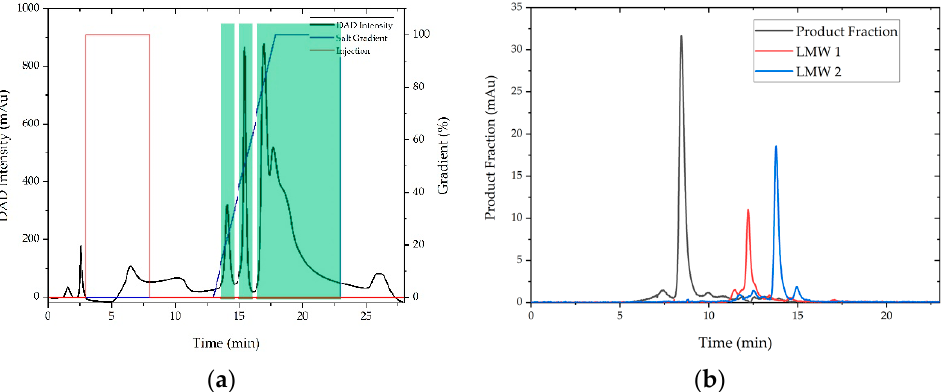
Figure 1. IEX Chromatogram of a 10 CV salt gradient ( a ), marked in green are the different eluent fraction. On the right ( b ) a representative SEC chromatogram of each eluent fraction is shown.